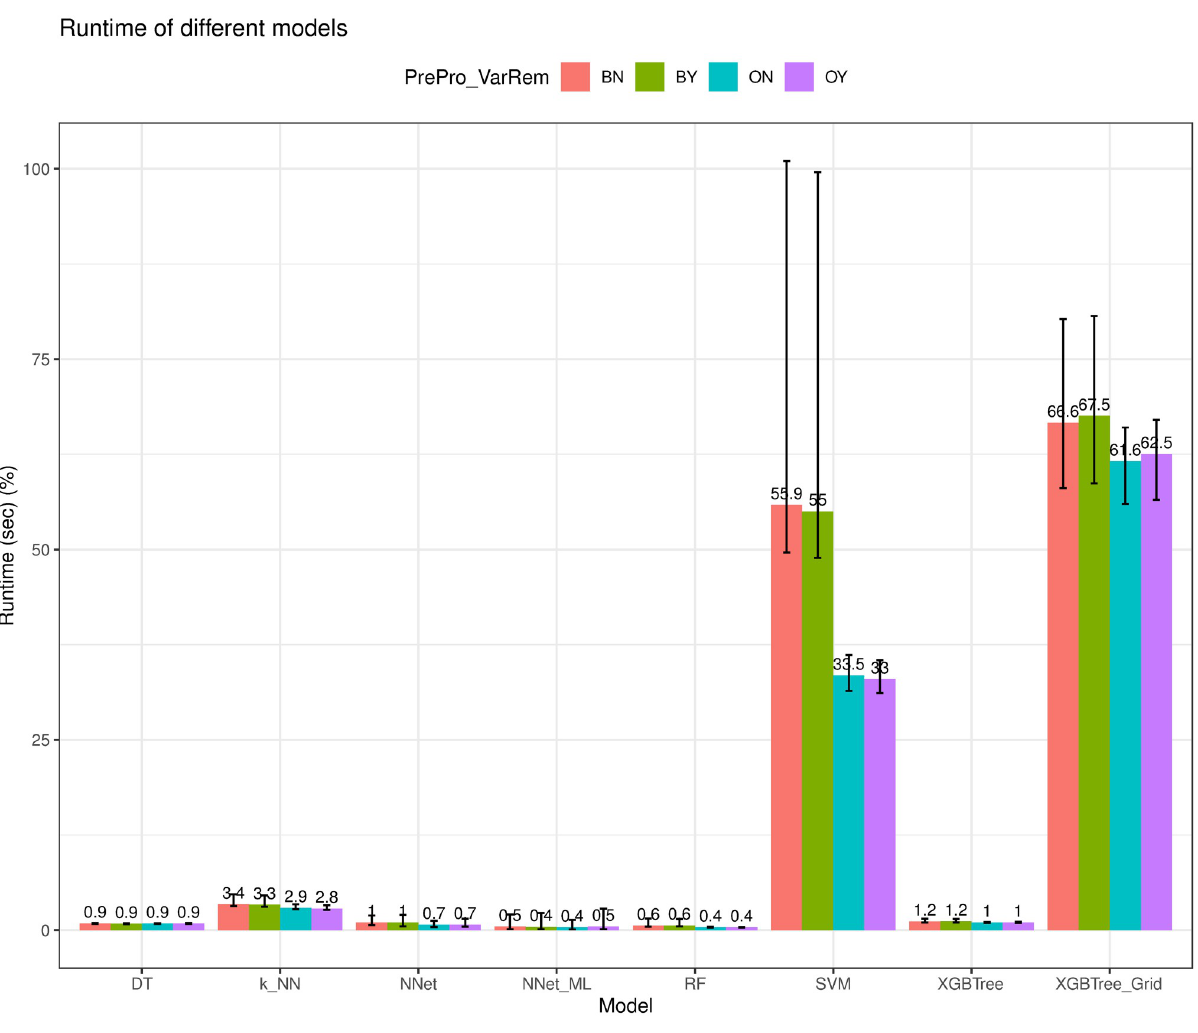
Fig 15. Average runtime for training different